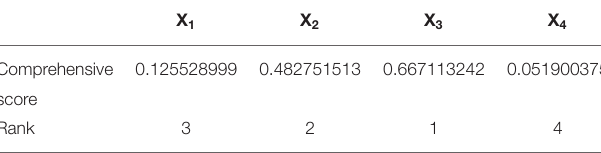
TABLE 7 | A comprehensive score of internet public opinion